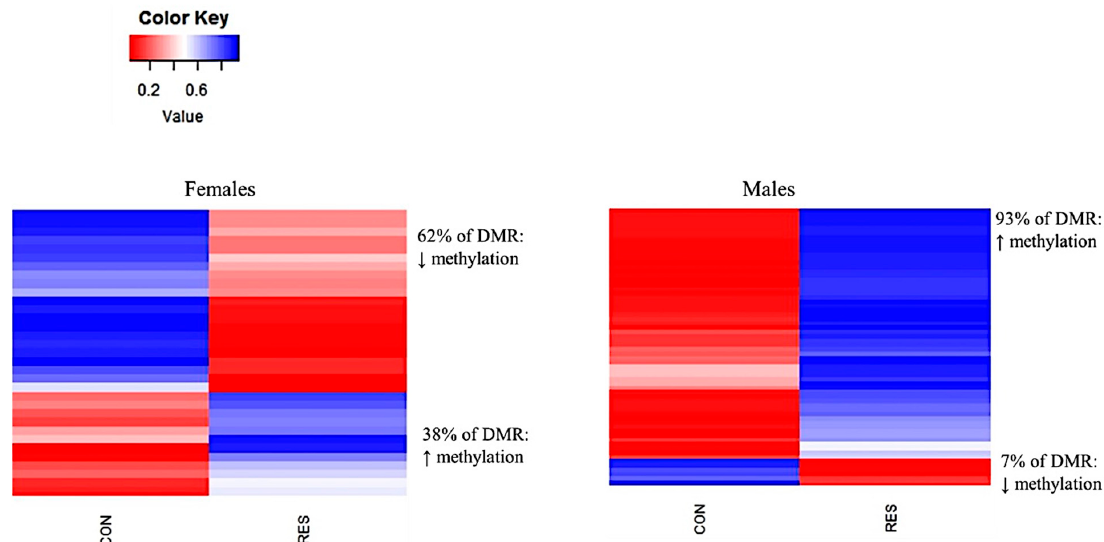
Figure 5. Exposure to nutrient restriction during gestation changes fetal pancreas tissue DNA methylation in a sex-specific manner. Fetuses collected from control- and restricted-fed ewes at d 135 of gestation are referred to as CON and RES, respectively. Blue = hypermethylated; red = hypomethylated. Regions were considered differentially methylated when p ≤ 0.001 and ∆ = 0.10.